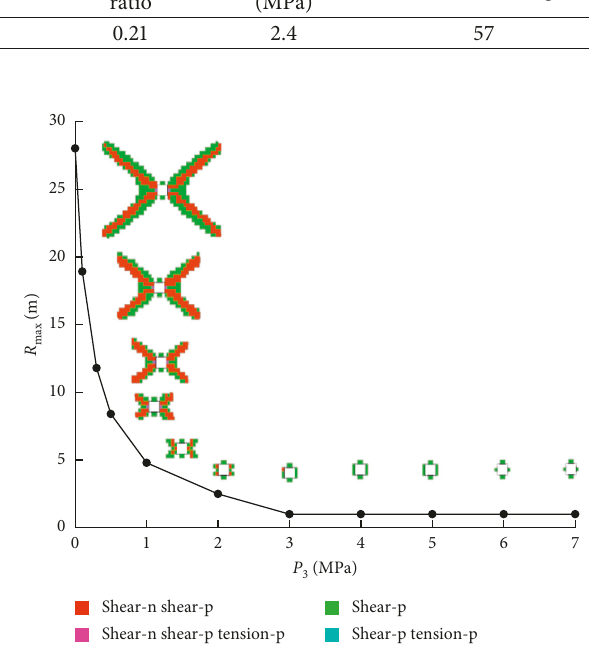
Figure 13: Plastic zone change curve in the B3 +6 preparation roadway during work face